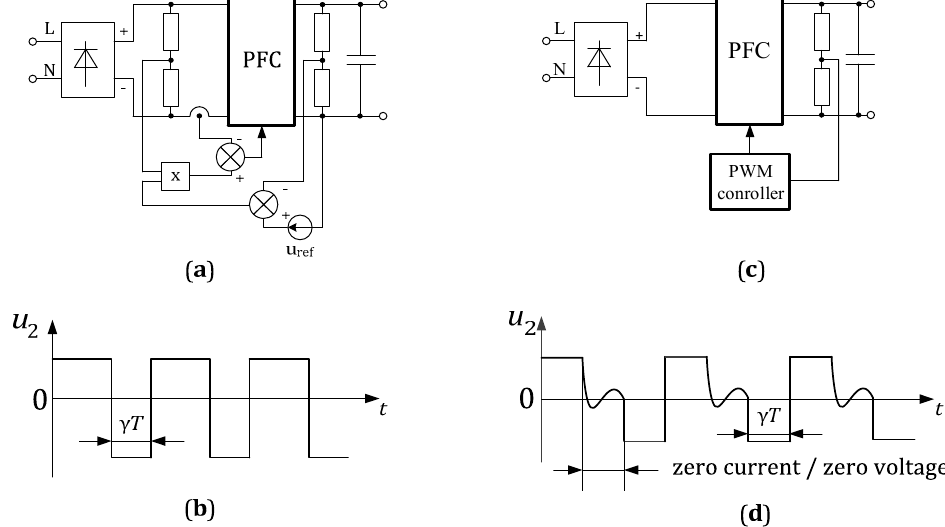
Figure 9. Generalized power factor correction (PFC) control system: ( a ) Continuous conduction mode (CCM) and ( b ) generalized corresponding output winding voltage; ( c ) discontinuous conduction mode (DCM) and ( d ) generalized corresponding output winding voltage.